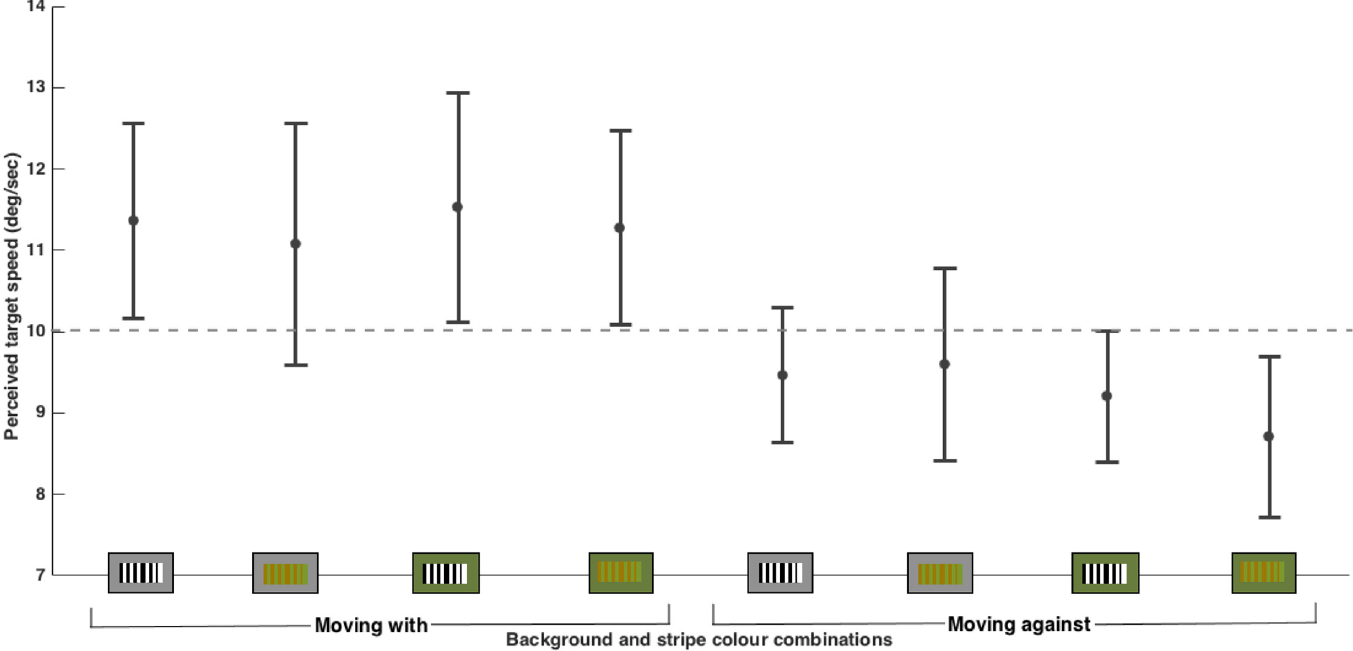
Fig 8. Mean perceived target speeds ( ± SD) for different colour combinations in Experiment 6 (N = 15 participants). The effect of the texture was enhanced by the green background so that the perceived speed was increased for the moving with direction, and decreased for the moving against direction, when compared to the grey